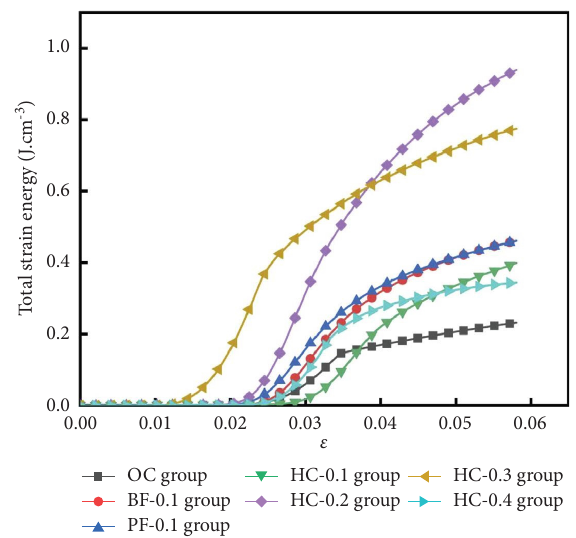
Figure 6: Evolution law of total strain